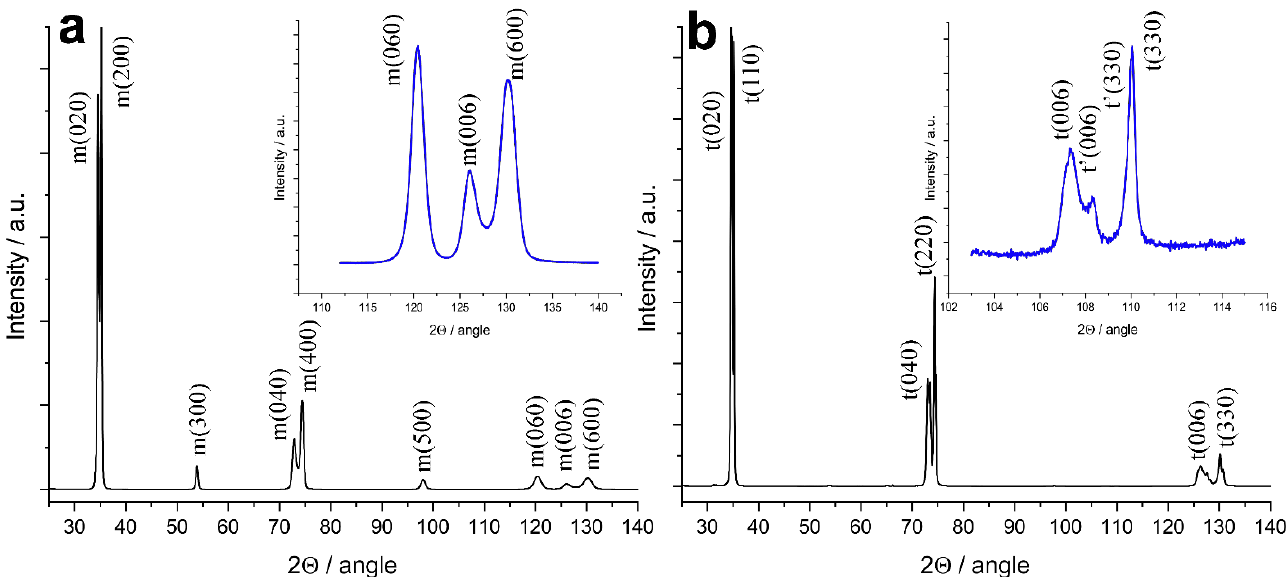
Figure 4. X-ray diffraction patterns of ( a ) (ZrO 2 ) 0.98 (Sm 2 O 3 ) 0.02 and ( b ) (ZrO 2 ) 0.96 (Sm 2 O 3 ) 0.04 crystals. Table 1. Phase composition and lattice parameters in different tetragonal phases of (ZrO 2 ) 1 − x (Sm 2 O 3 ) x